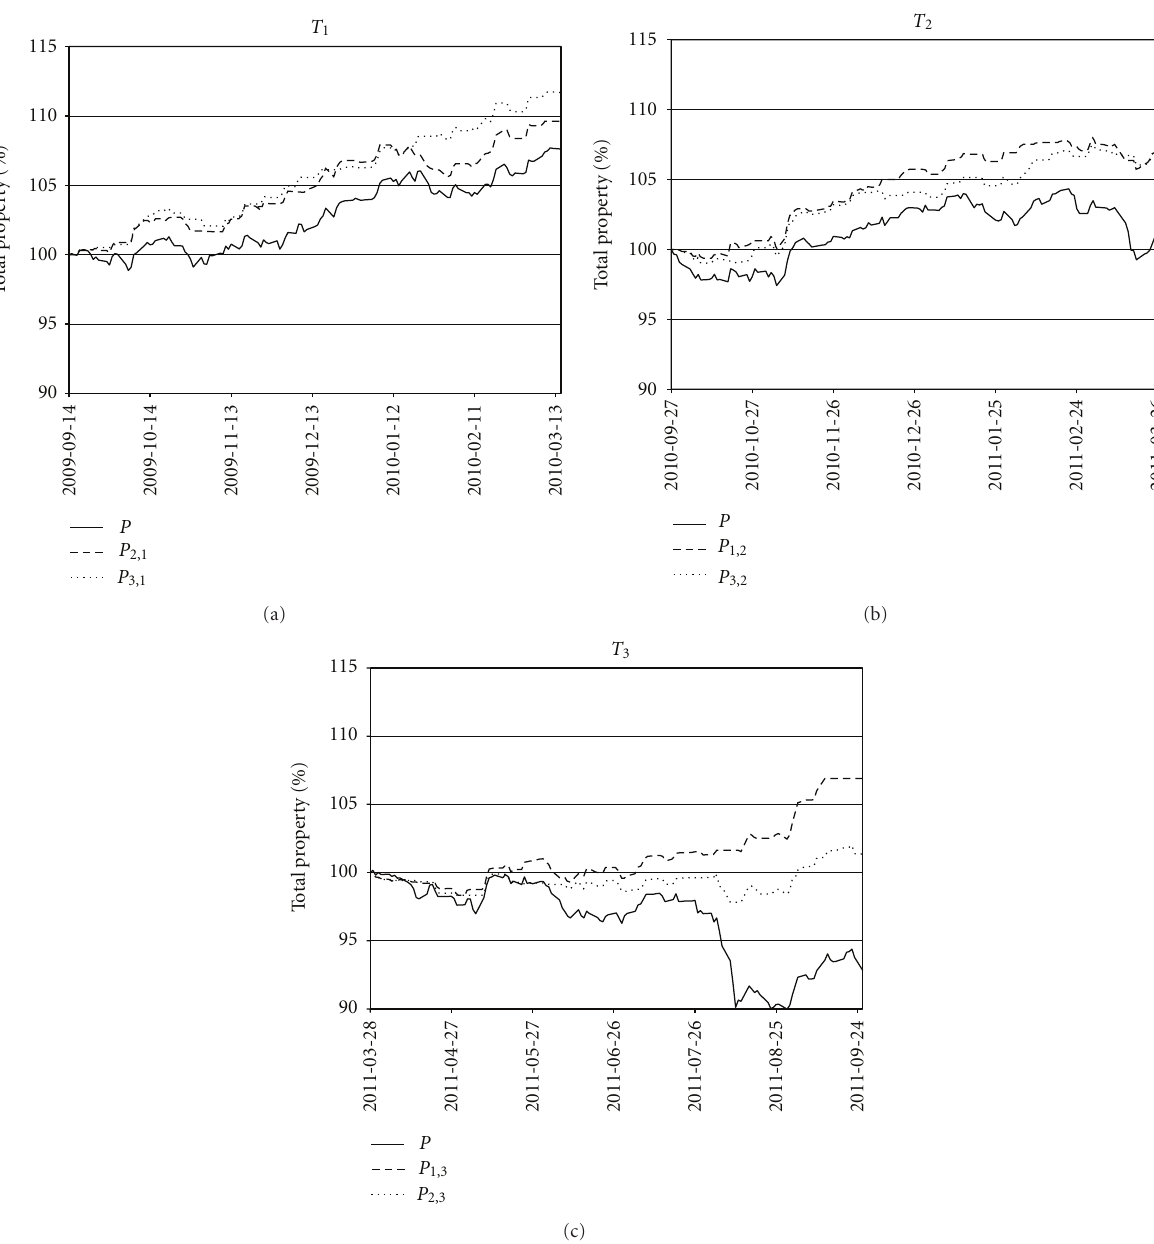
Figure 8: Performance of the investment strategy in di ff erent evaluation